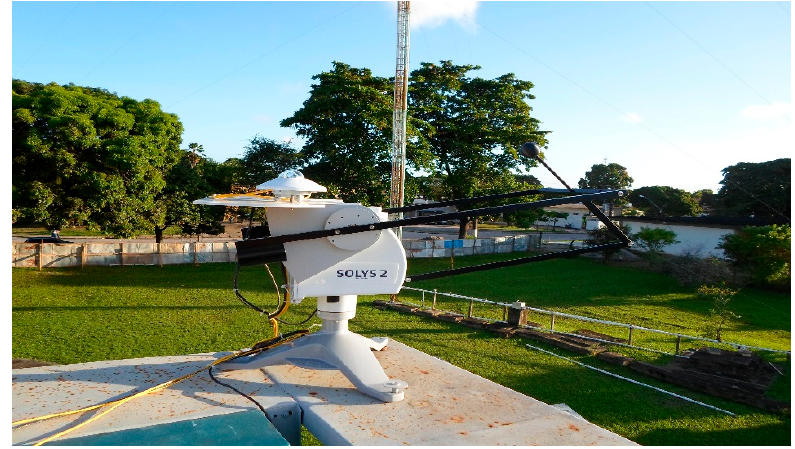
Figure 5. The solarimetric station for irradiance measurements.